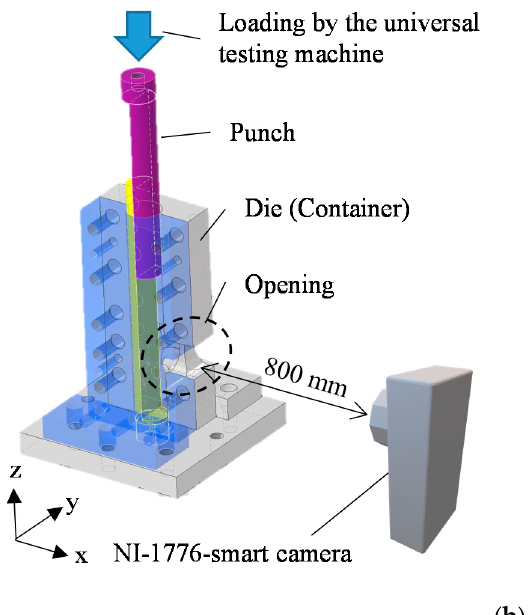
Figure 1. Illustration of local one-sided rubber bulging test: ( a ) Cross-sectional view; ( b ) General view.